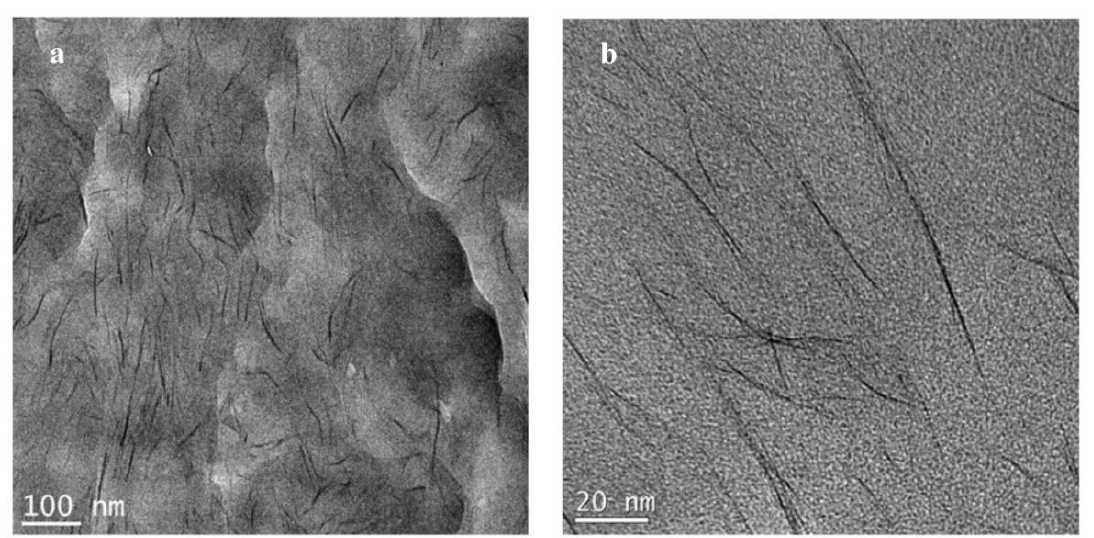
Figure 10. TEM micrographs for N6-30B prepared by solution compounding at low ( a ) and high ( b ) magnifications.